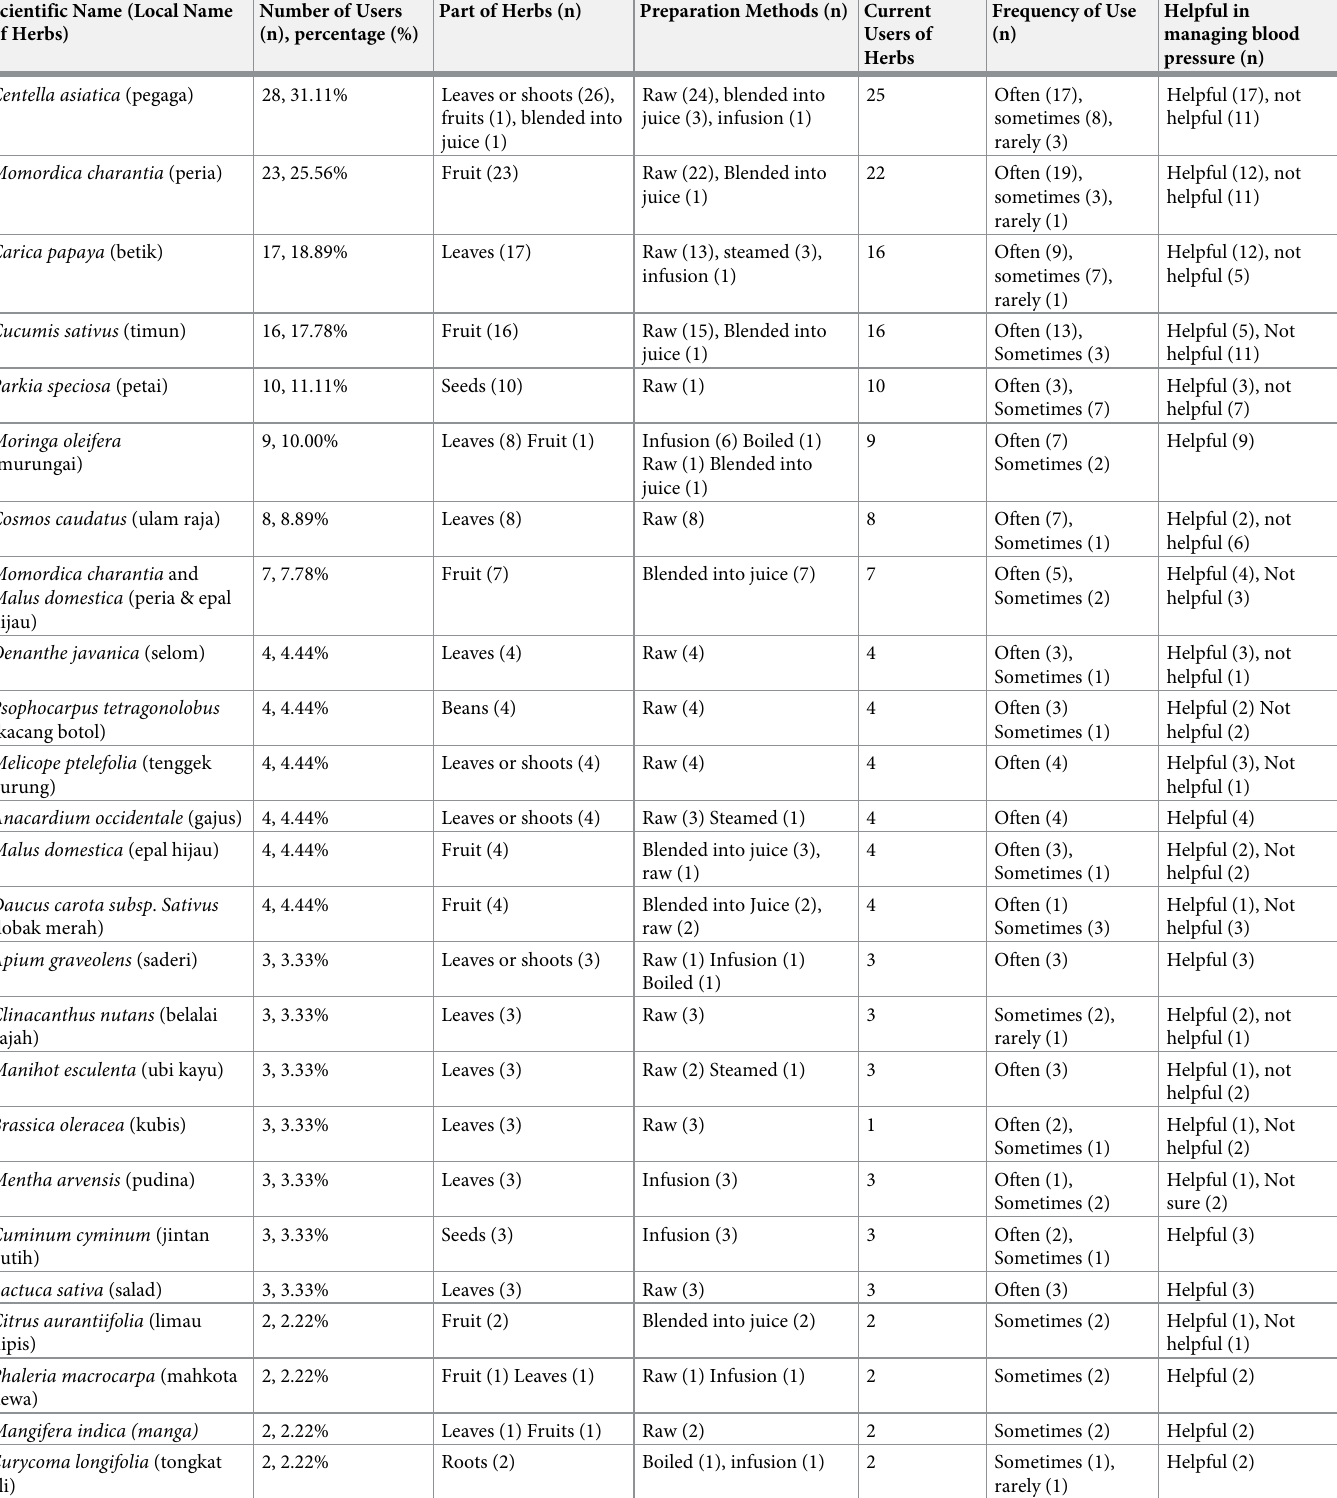
Table 2. Diversity of the herbs